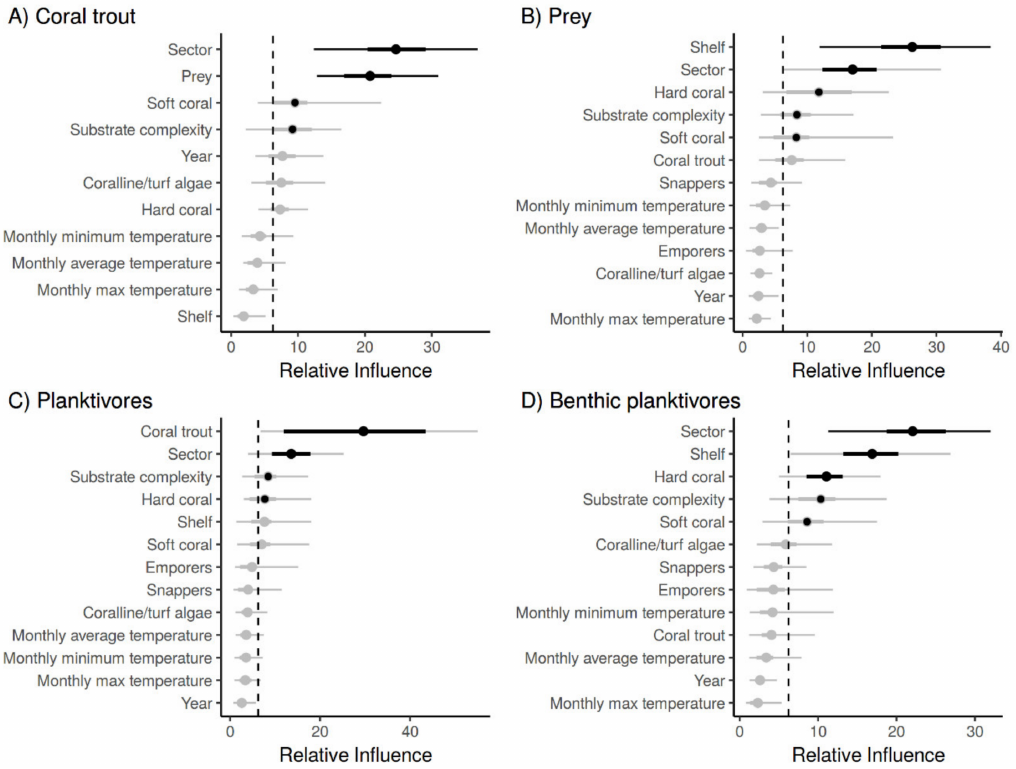
Figure 5. Relative influence (%) of predictor variables from boosted regression tree models for Great Barrier Reef planktivorous damselfishes, coral trout and their prey. Data are mean response and 95% confidence intervals from 100 iterations of the model for ( A ) coral trout, ( B ) planktivorous damselfishes identified as coral trout prey, ( C ) planktivores and, ( D ) benthic planktivores. The vertical dashed line represents equal contribution from each predictor variable, i.e., no variable has greater influence than any